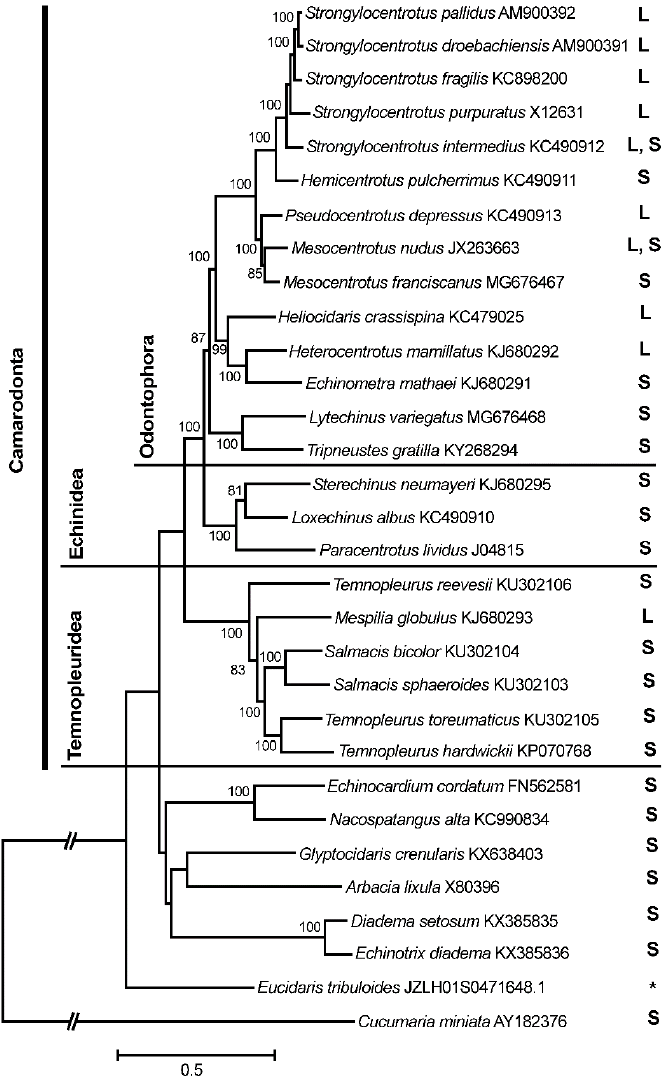
Figure 2. A maximum likelihood tree constructed using complete mitochondrial genomes of sea urchins (class Echinoidea). The tree is based on the general time reversible + gamma + invariant sites (GTR + G + I) model of nucleotide substitution. The mitochondrial genome of Cucumaria miniata (AY182376; class Holothuroidea) is used as an outgroup. The numbers at the nodes are bootstrap percentage probability values based on 500 replications (values below 75% are omitted). The species above the first (on top) horizontal line belong to the superfamily Odonthophora; above the second horizontal line, to the infraorder Echinidea; above the third horizontal line, to the order Camarodonta including the infraorders Echinidea and Temnopleuridea. The ND6 L and S variants are indicated by the corresponding letters on the right: L, long (165 amino acids) ND6 variant; S, short (162 amino acids) ND6 variant; L, S, both ND6 variants detected for Strongylocentrotus intermedius and Mesocentrotus nudus . The Eucidaris tribuloides ND6 variant (indicated by asterisk) is shorter than the S variant of other sea urchins due to the deletion of seven amino acids at the C-terminus (see Figure